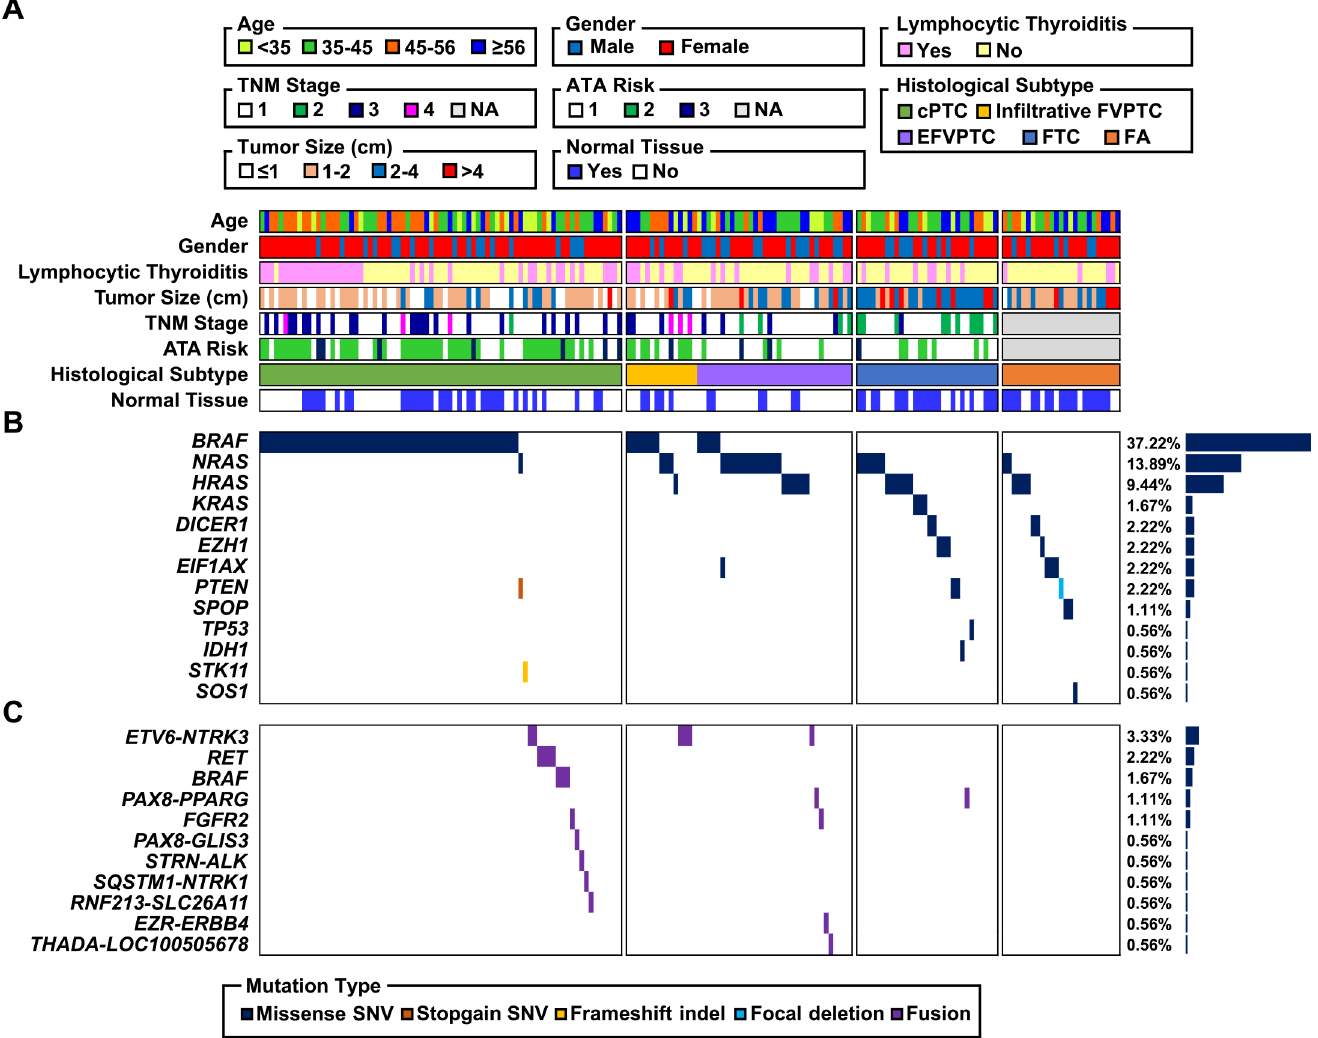
Fig 1. The mutational landscape of thyroid tumors. Each column represents an individual sample. (A) Age, gender, the presence of lymphocytic thyroiditis, tumor size, TNM Classification of Malignant Tumors stage, American Thyroid Association risk stratification, availability of matched normal tissue, and histological subtype. (B) Frequency of small size mutation by gene (right) and distribution of mutation across the 180 tumors (middle). (C) Frequency of fusion mutation by gene (right) and distribution of mutation across the 180 tumors